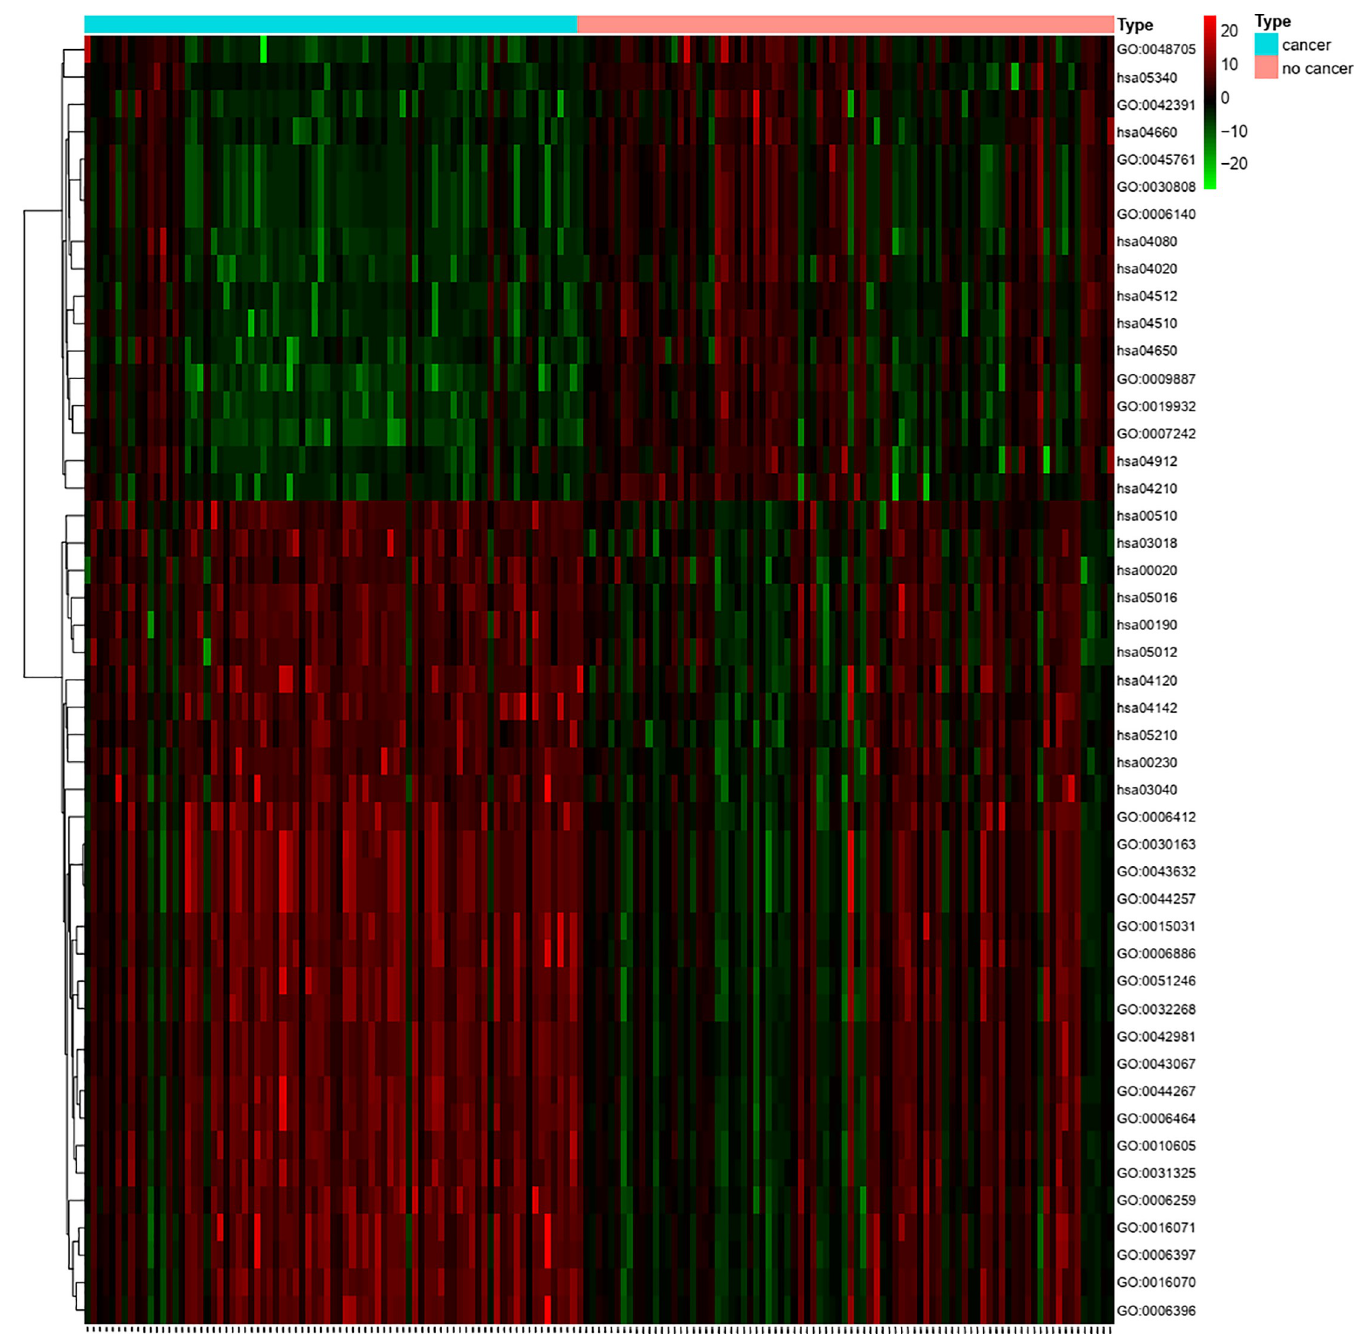
Fig 4. Functional score heat map for each sample. (The closer to red, the higher the score; the closer to green, the lower the score.).